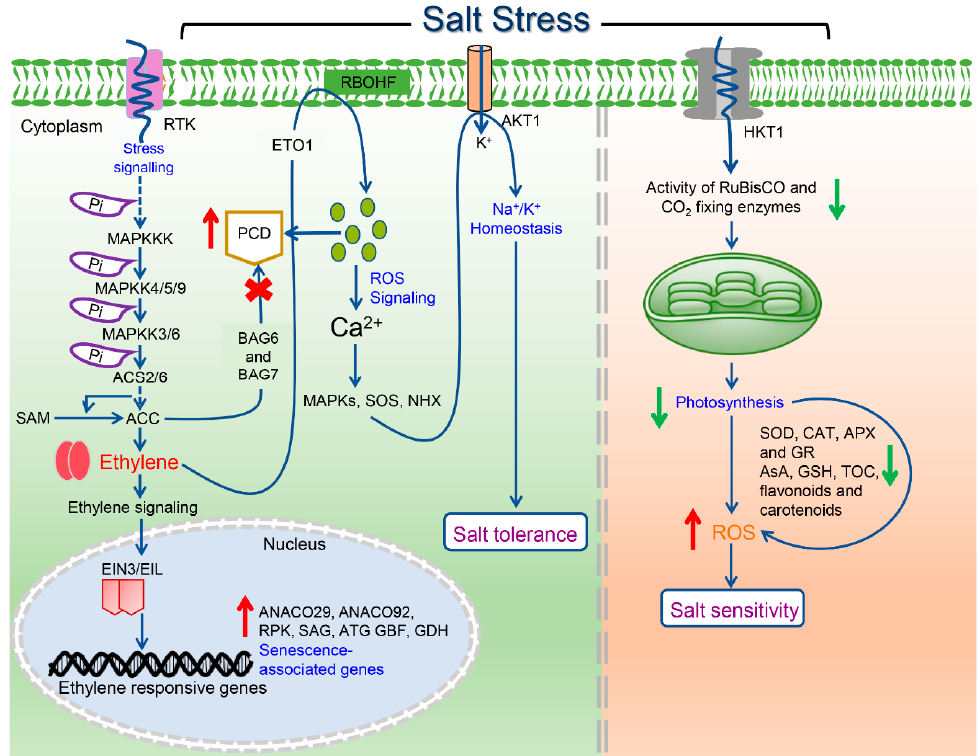
Figure 4. A schematic representation of ethylene regulation under salinity stress. When plants encounter ionic imbalance, nutrient imbalance, and osmotic stress under salinity stress, activation of upstream mitogen activated protein kinase kinase kinases (MAPKKKs) leads to the gradual phosphorylation and successive activation of downstream mitogen activated protein kinase kinases (MAPKKs) and MAPKs that further phosphorylates ACS2/6. The phosphorylated ACS2/6 stabilizes and thus enhances the production of ethylene through ethylene biosynthesis. Consequently, the downstream signaling activates the transcription of several ethylene-responsive genes. The transcription level of BAG ( Bcl-2 -associated athanogene) family genes is suppressed by ethylene (1-aminocyclopropane-1-carboxylic acid (ACC)) to inhibit salinity-induced plant cell death (PCD). On the other hand, ethylene enhances ROS signaling to increase calcium ions, which in turn regulate MAPK, salinity overly sensitive (SOS), and Na + / H + exchangers (NHX) through Na + / K + homeostasis to provide salinity stress tolerance. Salinity stress reduces the CO 2 -fixing enzymes in chloroplast that eventually produce ROS. Scavenging of ROS occurs through both enzymatic (superoxide dismutase (SOD), catalase (CAT), ascorbate peroxidase (APX), and glutathione reductase (GR)) and nonenzymatic (ascorbic acid (AsA), glutathione (GSH), α -tocopherol (TOC), flavonoids, and carotenoids) antioxidant defense